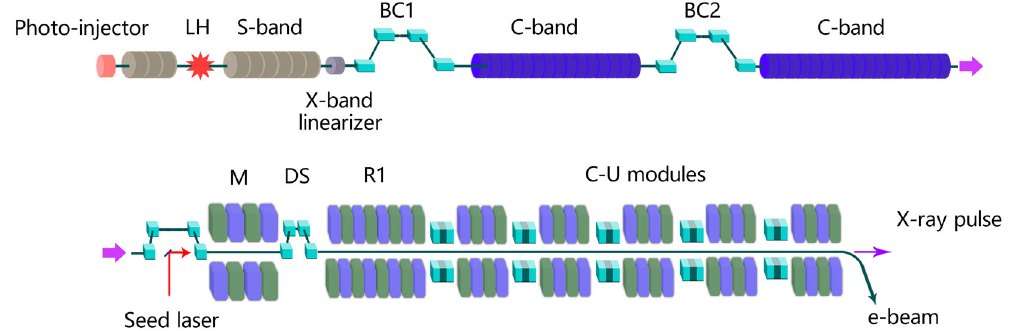
FIG. 5. Layout of the